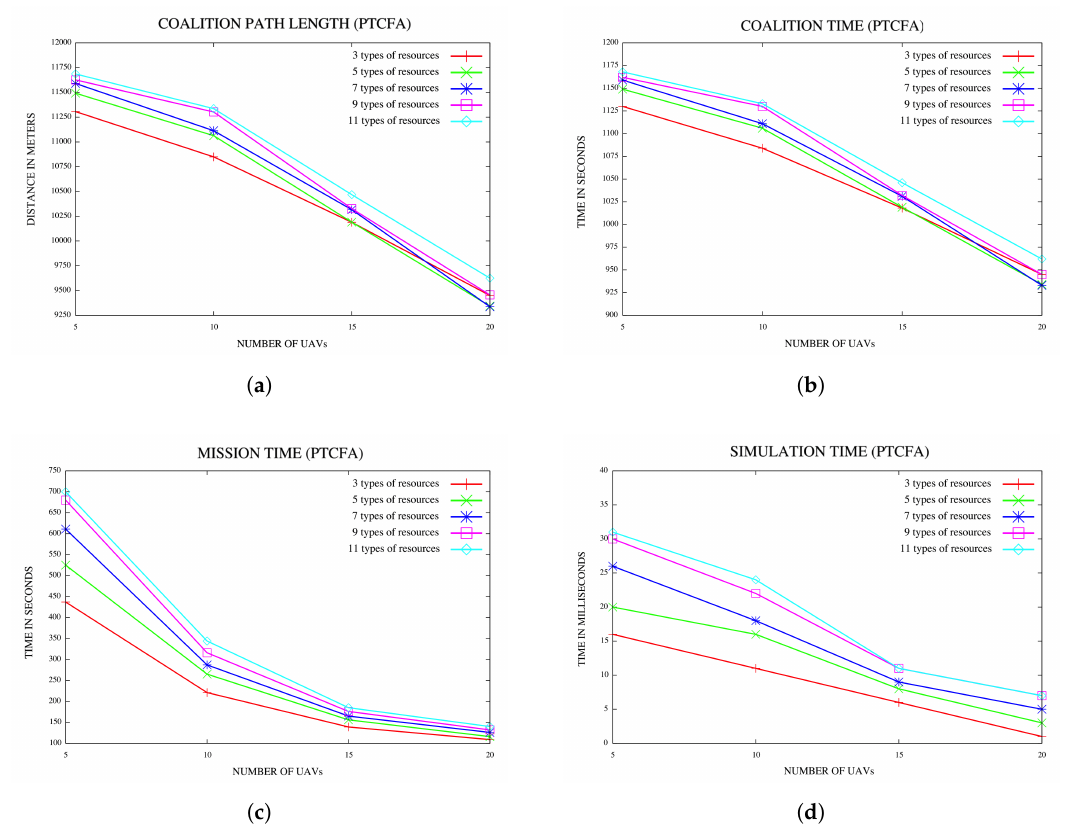
Figure 12. ( a ) Coalition path lengths for various numbers of resources for 15 locations; ( b ) coalition times for various numbers of types of resources for 15 locations; ( c ) mission time for various numbers of types of resources for 15 locations; ( d ) simulation time for various numbers of types of resources for 15